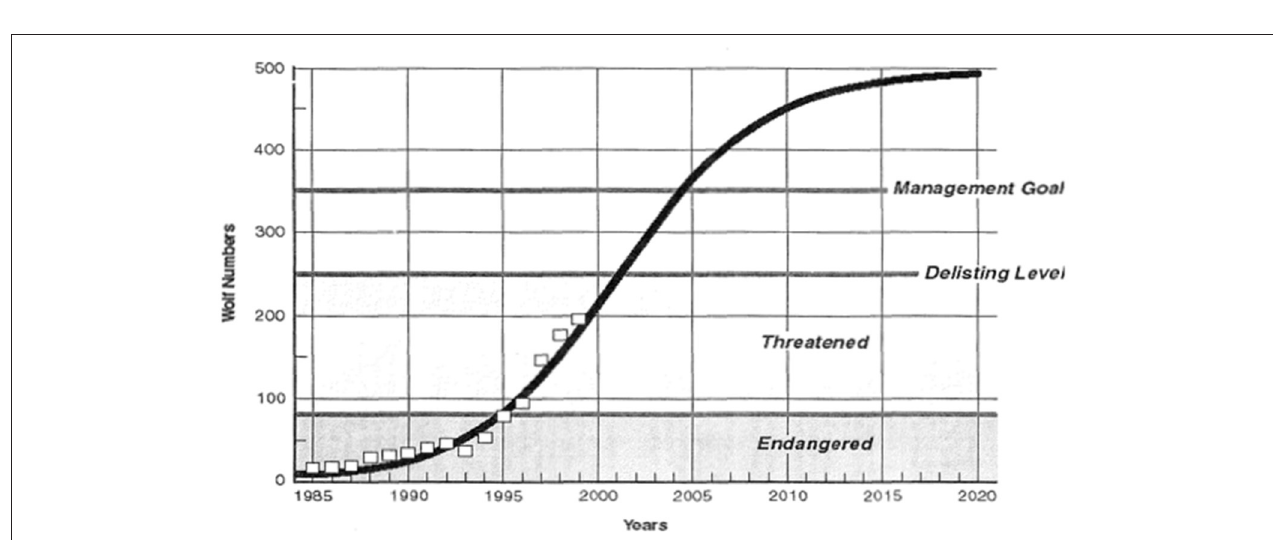
FIGURE 2 | The 1999 Plan Figure 7 “Wisconsin Wolf Population Growth If Carrying Capacity Is 500 Wolves.” The 1999 Plan forecast wolf population growth to 2020 from a superimposed, generic logistic growth curve ( WDNR, 1999). The model treated the population estimates as a single time series, although according to Treves (2019a) this should have been presented as two time series because of a change in wolf census methods in the winter of 1994–1995. The “Delisting Level” was set at 250, when the legal removal of wolves from the state’s list of threatened and endangered species would begin. The “Management Goal” codified a population target (N goal = 350), which is still the state population target today ( USFWS, 2020). Vertical lines represented 5-year intervals and horizontal lines represented hundreds of wolves. Arguably, the explicit value judgments (Delisting Level and Management Goal) appear as outputs of the model, though their origin was not explained in WDNR